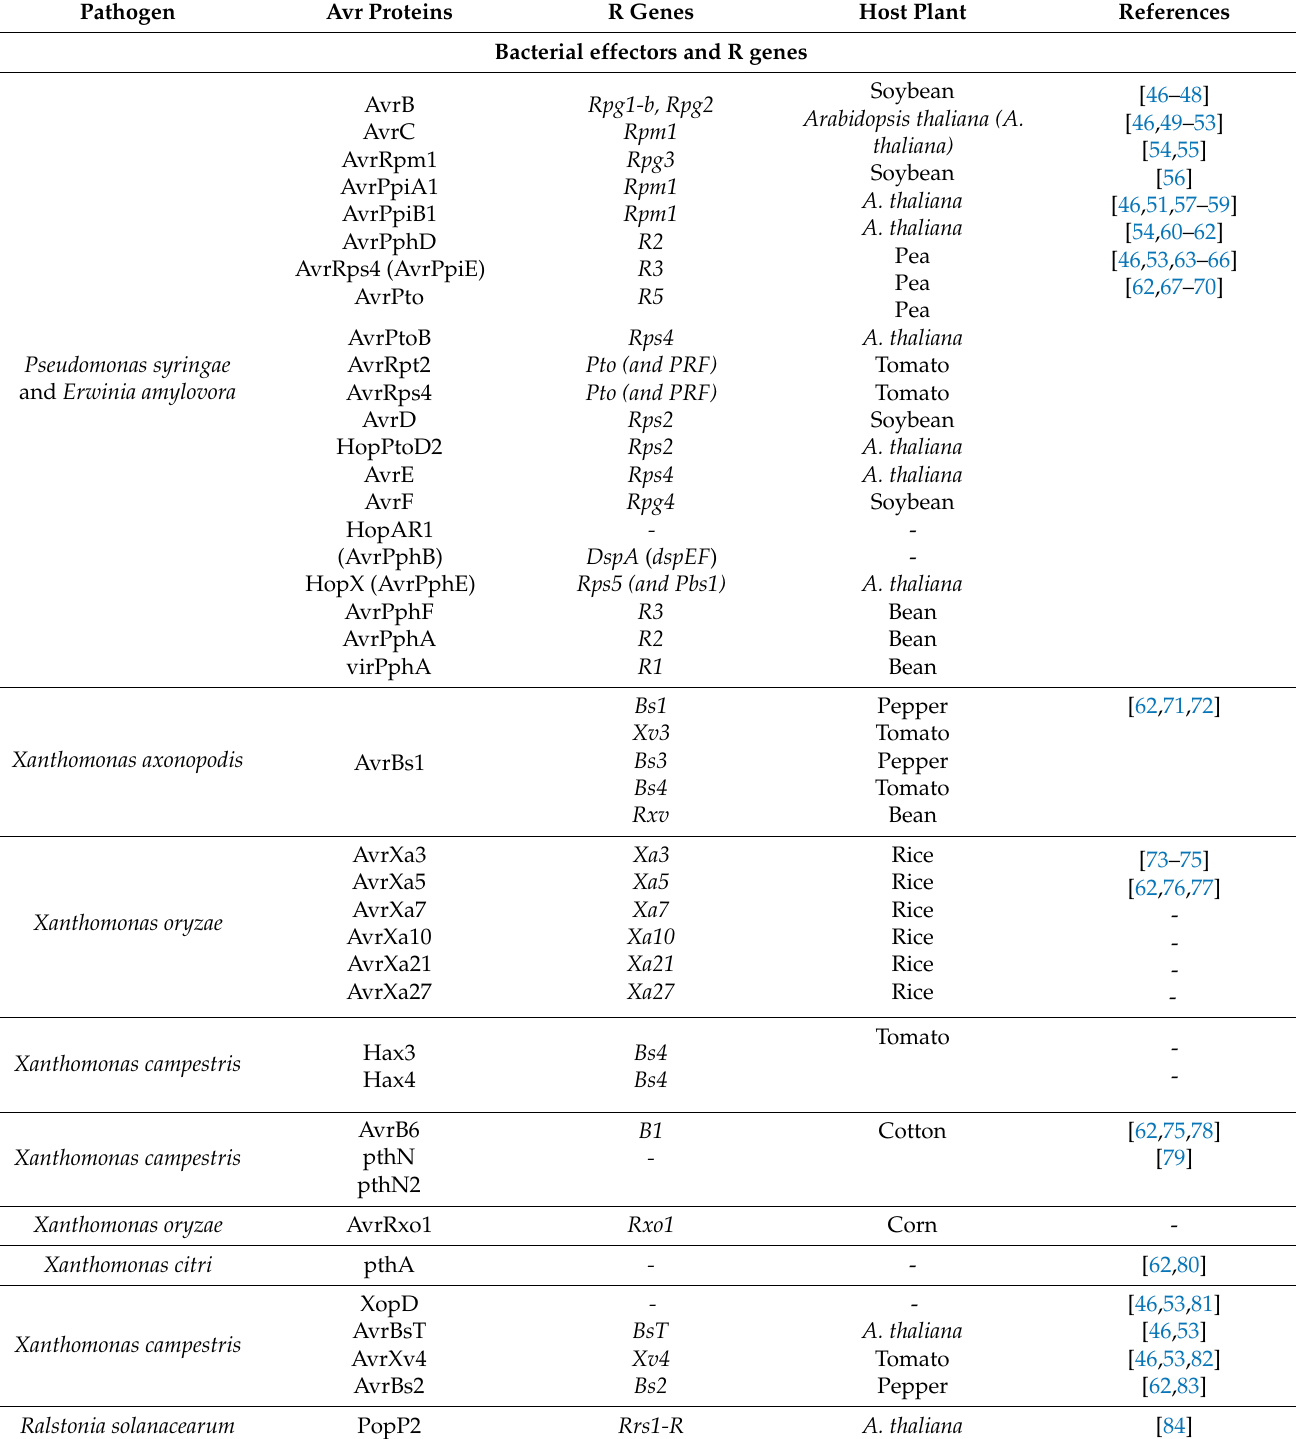
Table 1. Different effectors produced by pathogens and their R